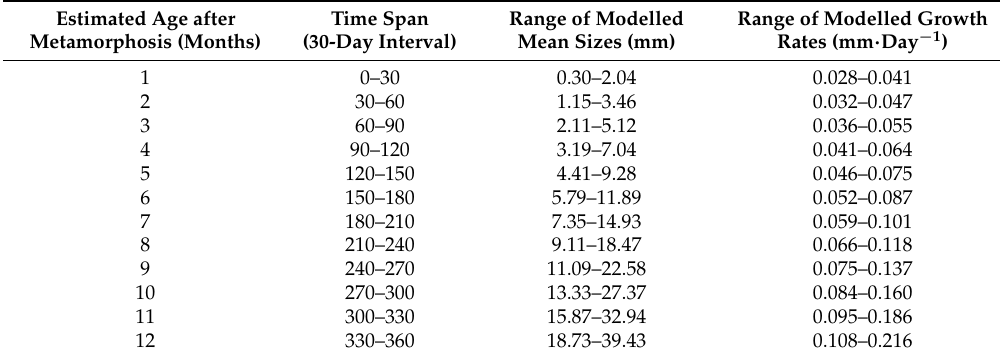
Table 1. Range of modelled mean sizes and growth rates for estimated age (in months after metamorphosis) and different time spans (30-day